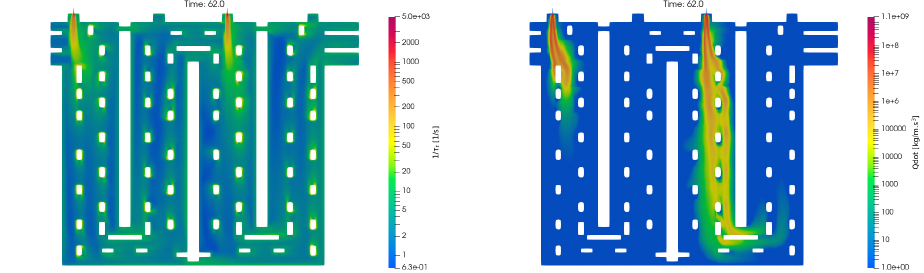
Figure 5. Inverse of the turbulent time scale 1/ τ t ( left , logarithmic scale) and combustion energy source term (cid:101) ˙ Q chem ( right , logarithmic scale) on the symmetry plane at t = 62 s of computation